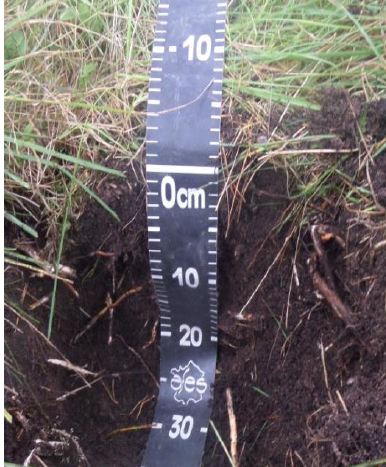
Figure 4. The photo of Sandy loam gray-humus soil formed on rock material (Arenosol — WRB).